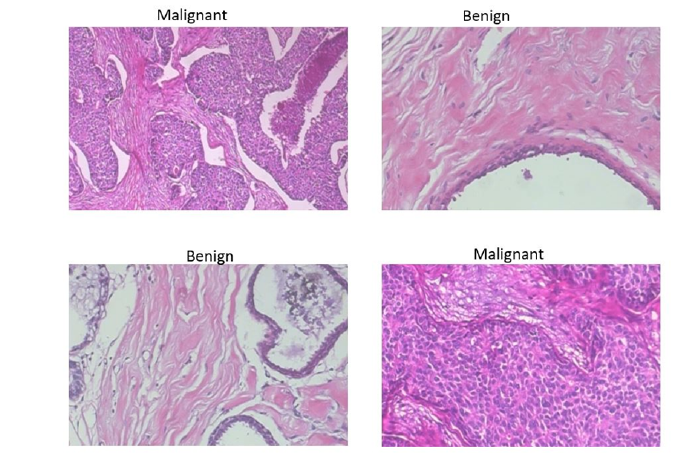
Figure 11. Four sample test images with their predicted labels from our proposed algorithm. Experiment: ROC Curves The receiver operating characteristic (ROC) curve, shown in